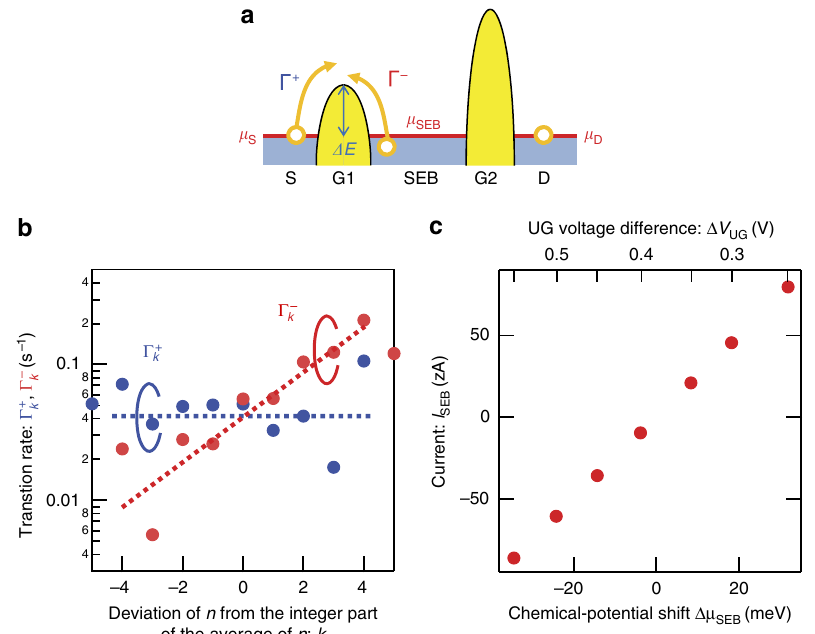
Figure 2 | Directionally asymmetric electron transport in transistors. ( a ) Energy-band diagram along the S and D, where m S , m D and m SEB are chemical potentials at the source (S), drain (D) and single-electron box (SEB). For simplicity, we consider the electron shuttling between the S and SEB. G þ and G (cid:3) are transition rates from the S and SEB, respectively. D E is energy barrier height when an electron in the S surmounts the energy barrier. ( b ) Transition rates G k þ and G k (cid:3) as a function of k , which is the deviation in n from the integer part of the average. They are the transition rates for electrons to enter ( þ ) and leave ( (cid:3) ) the SEB at k . The dotted lines show expected values. The details are explained in Supplementary Note 3. Since the number of data points at | k | 4 4 is relatively small, there are large errors at | k | Z 4. ( c ) Current across the SEB I SEB generated by periodic switching without feedback, estimated with single-electron counting statistics, as a function of the shift in m SEB ( D m SEB ) when the state is switched from A to B. The upper axis depicts D V UG , which is the difference in voltage applied to the upper gate (UG) when the state is switched from A to B. State A and B are alternately switched every 4s. Current is given by D ne /8, where D n is the number of electrons transferred from S to D when the state is switched from A to B. The factor of 8 originates from the time it takes for the state changes from A to B and back to A, that is, 2 (cid:2) 4s. The details, including the evaluation of D m SEB , are explained in Supplementary Note 4.